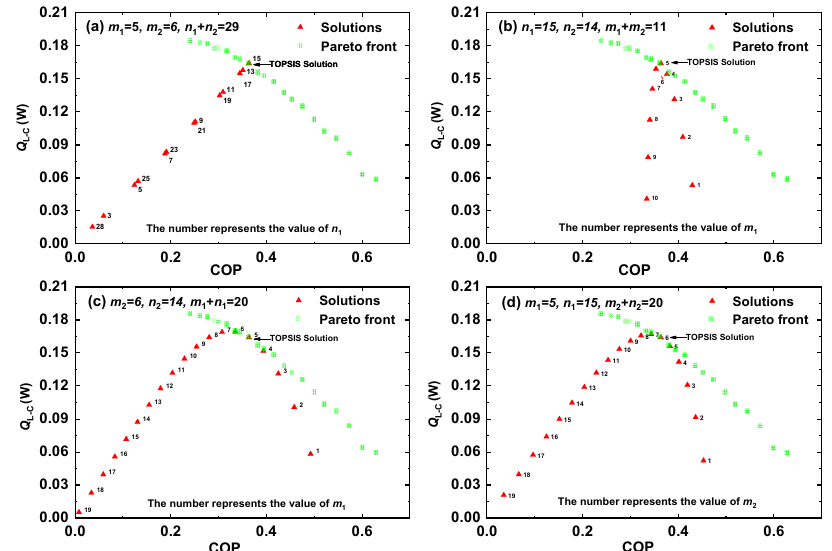
Figure 13. The effect of element number allocated to each stage on the performance of CTE under four different conditions: ( a ) different number ratio between the top and the lower stage of TEC when the element number allocated to TEG is fixed; ( b ) different number ratio between the top and the lower stage of TEG when the element number allocated to TEC is fixed; ( c ) different number ratio between the TEG module and the TEC module for the two top stages of CTE when the element number allocated to the two lower stages of CTE is fixed; and ( d ) different number ratio between the TEG module and the TEC module for the two lower stages of CTE when the element number allocated to the two top stages of CTE is fixed.